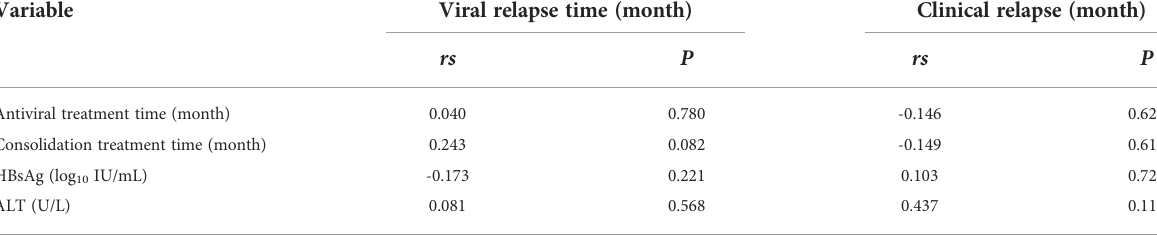
TABLE 4 Correlation between recurrence time and baseline